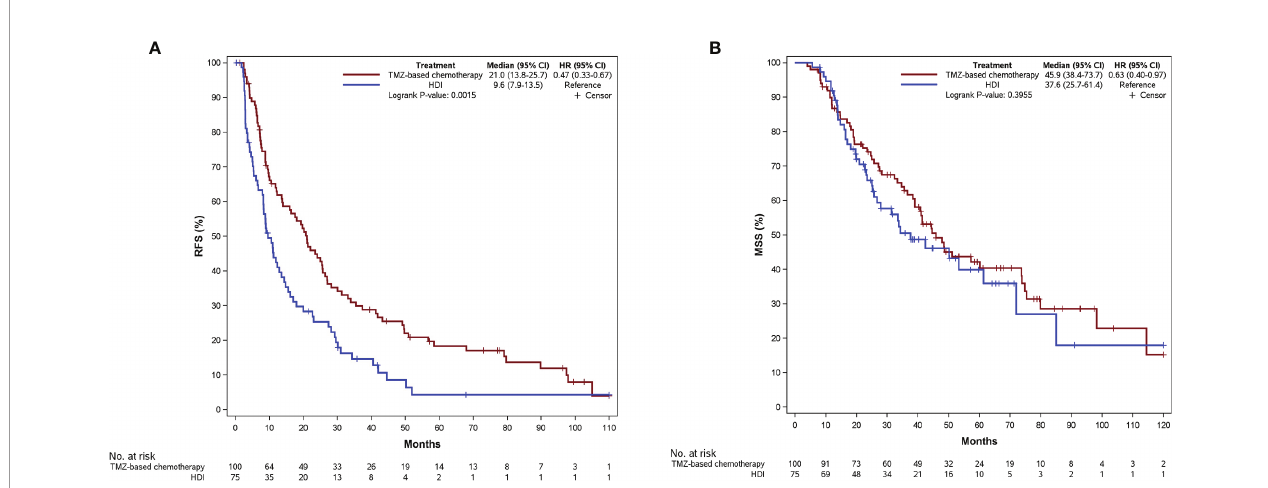
FIGURE 2 | Kaplan-Meier curves of RFS (A) and MSS (B) according to patients receiving different adjuvant regimens. RFS, relapse-free survival; MSS, melanoma- speci fi c survival; TMZ, temozolomide; HDI, high-dose interferon-a2b.